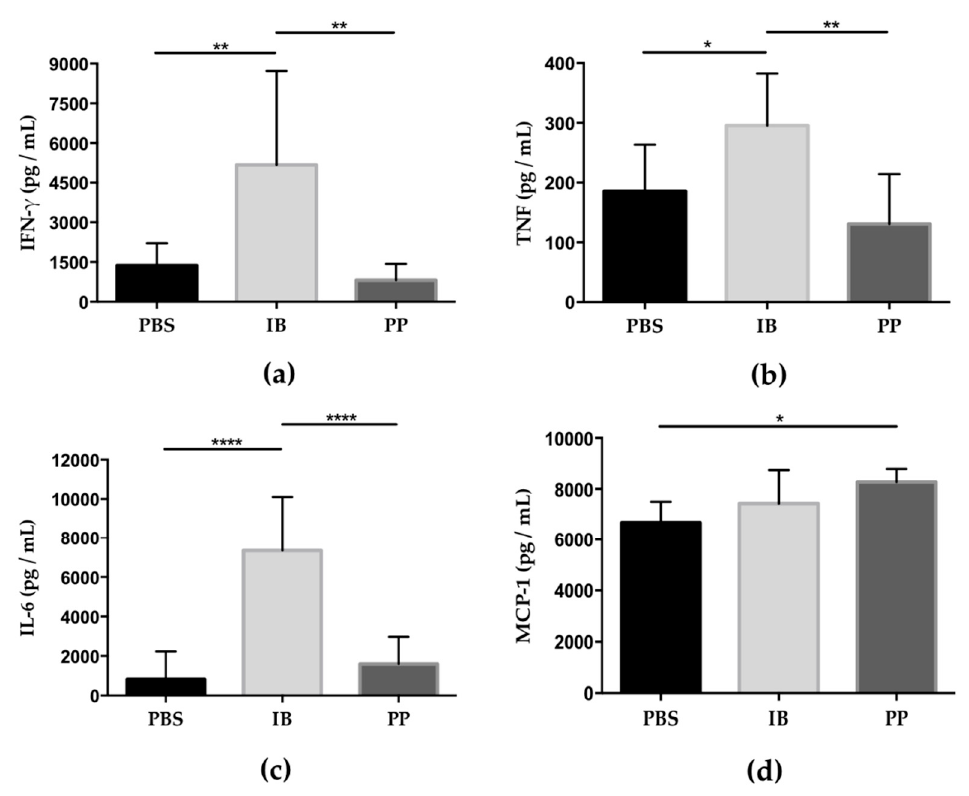
Figure 4. Cytokine levels in the ascites fluid of mice infected with T. gondii . Concentrations levels of interferon-gamma (FN- γ ), tumor necrosis factor (TNF), and interleukin-6 (IL-6) were significantly elevated in mice treated with immunobiotic (IB) compared to mice in the control group (PBS) and paraprobiotic (PP) but without significant di ff erences between the PBS and PP groups ( a–c ). The administration of the paraprobiotic treatment significantly increased the concentration of monocyte chemoattractant protein-1 (MCP-1) compared to the group treated with PBS, however, no significant di ff erence between the PP and IB groups or between the IB and PBS groups ( d ). Data were combined from two individual experiments with three to five mice per group. Values represent the means ± SD. * p < 0.05; ** p < 0.01; **** p < 0.0001. PBS) phosphate bu ff ered saline; IB) immunobiotic; PP) paraprobiotic.